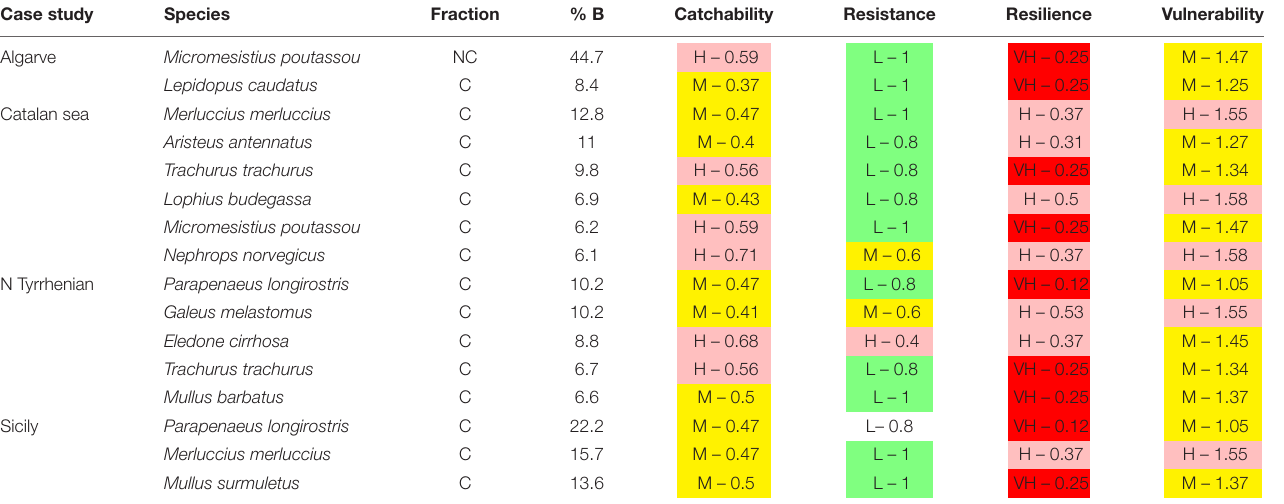
TABLE 3 | Species accounting to 50% of biomass across sampling times in the case studies. Case study